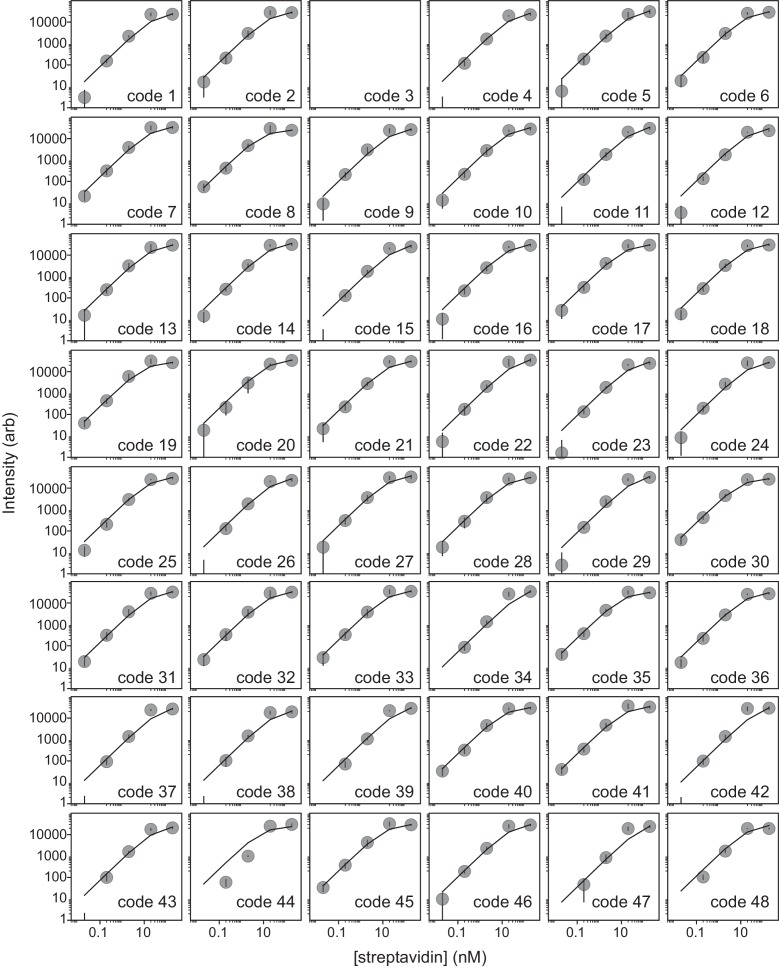
Streptavidin binding assay can be used to determine peptide loading density.Scatter plots of measured intensity per bead (median ± s.e.m) as a function of Alexa-647-labeled streptavidin concentration demonstrate that intensities saturate at approximately 20 nM labeled streptavidin. Each reaction includes ~7000 total beads in a 100 μL volume, suggesting that each individual bead displays ∼2 × 108 peptides.